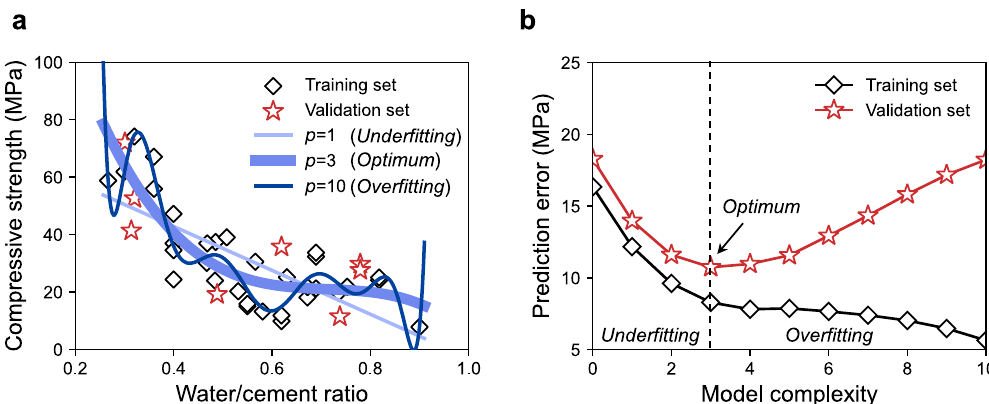
Fig. 5 Trade-off between under fi tting and over fi tting. a An illustrative low-dimensional example in concrete science, consisting of 40 real concrete mixtures (from the publicly accessible concrete compressive strength dataset 24,112 in Table 2) with one input (water/cement ratio) and one output (compressive strength, MPa). The dataset was divided into a training set and a validation set by an 80/20 split. Three polynomial models with polynomial degrees p = 1, 3, or 10 were fi tted to the training data. The polynomial of degree three was identi fi ed as the optimal model based on the good prediction performance on the validation set, while those of degrees one and ten were showcased as under fi tting (too simple to capture patterns in the data) and over fi tting (too complex such that noise was learned), respectively. b Error (root mean square error, MPa) in the prediction of the training and validation sets as a function of model complexity (i.e., polynomial degree herein). Simple statistical models may under fi t the data, whereas complex models tend to over fi t without extreme caution. The optimal model complexity yields the best generalization performance. As machine learning models are generally much more complex than traditional statistical models, proper implementation and validation are required, especially when dealing with small datasets.